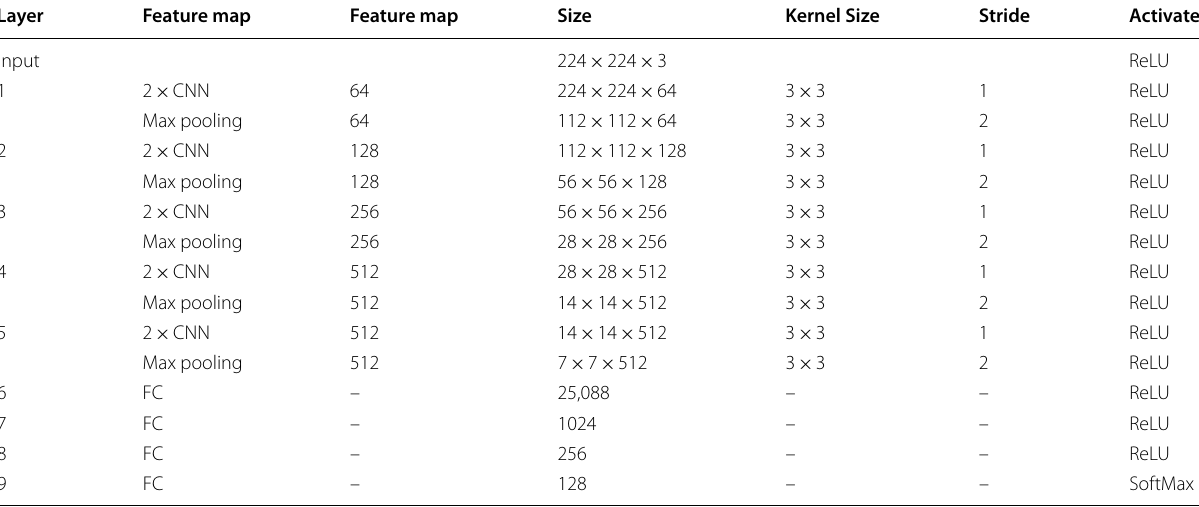
Table 6 The architecture of